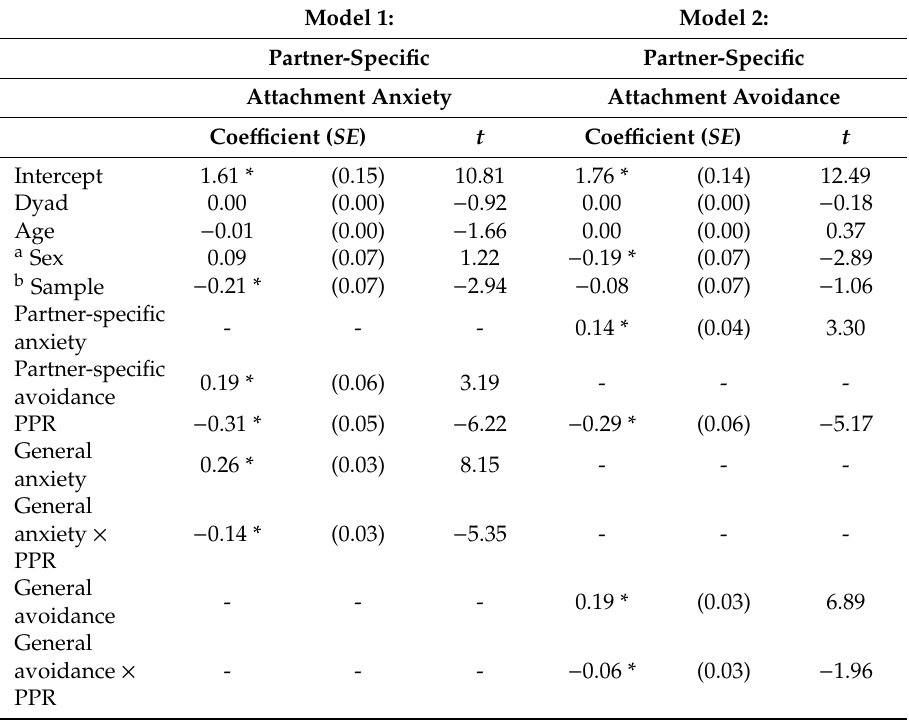
Table 3. Partner-specific attachment anxiety and avoidance predicted by perceived partner responsiveness for generally anxiously attached and generally avoidantly attached individuals.